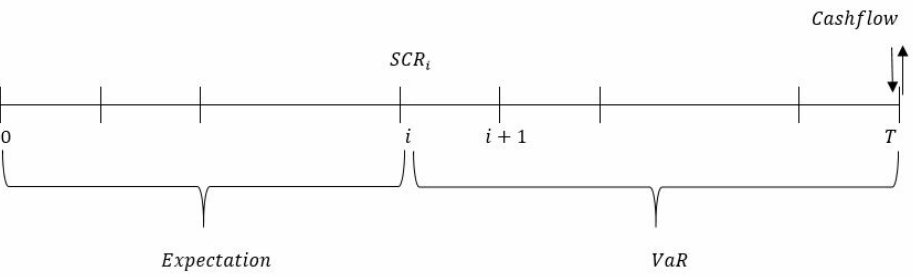
Figure 3. Computation of the successive SCR i in the Levantesi and Menzietti’s